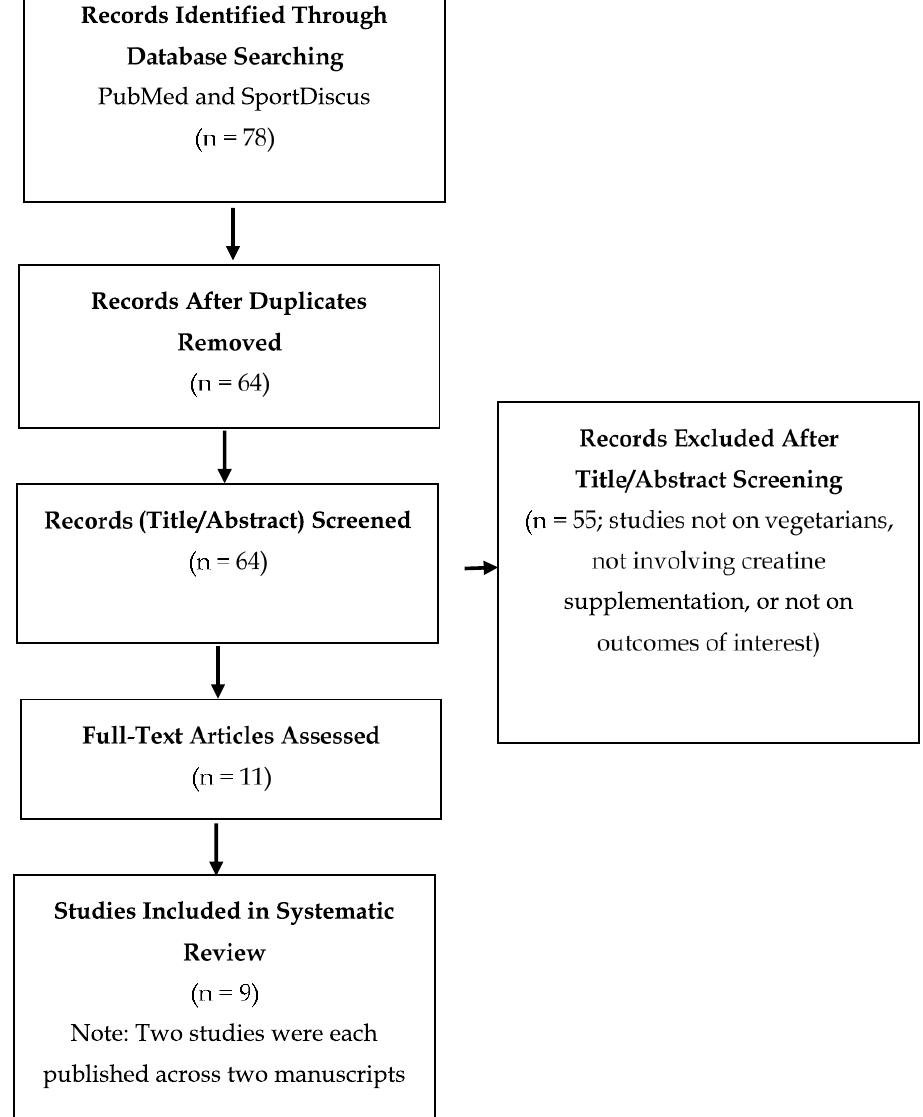
Figure 1. PRISMA diagram: Flow chart of study section process.